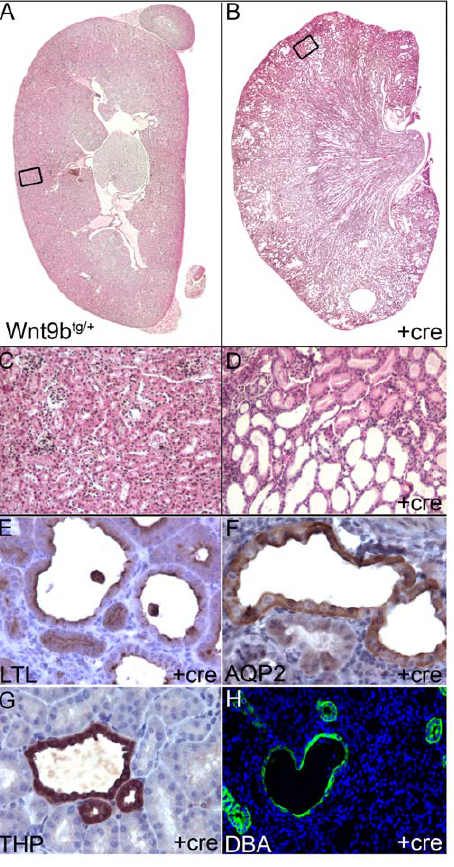
Figure 4. Kidney cysts in double transgenics can be found throughout all segments of the nephron. (A–D) H&E staining of adult kidneys demonstrates numerous cystic dilatations in the cortex and outer medulla in Six2-cre tg/ + , Wnt9b tg/ + double transgenics and a normal kidney architecture in Wnt9b tg/ + controls. (E–H) Cysts were derived from proximal tubules (LTL-positive) and distal loop of Henle (THP-positive). DBA-positive and Aquaporin 2- positive collecting duct cysts were also identified in smaller number. Since Six2 -cre is not expressed in the collecting duct, these cysts are produced through signaling from neighboring cells or secondary to dilatation of more proximal segments.